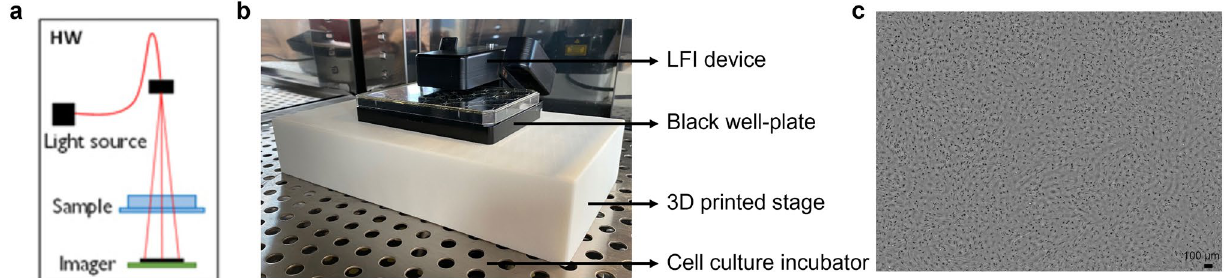
Figure 1. Lens-free imaging. (a) Schematic of the lens-free imaging set-up (figure adapted from 31 ). (b) Picture of the LFI microscope, mounted inside a standard cell culture incubator with a 3D printed stage for well-plate support. (c) Reconstructed phase image of detaching cells, acquired with the LFI set-up. The black scale bar represents 100